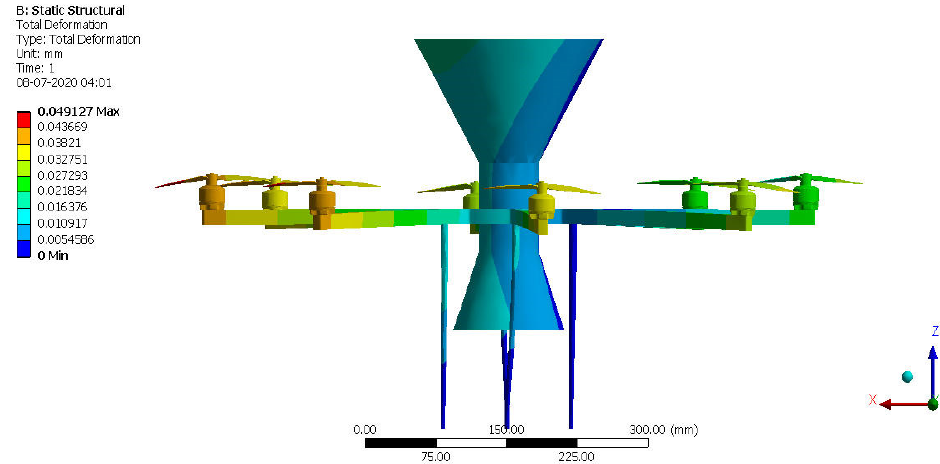
Figure 32. Variations of displacement in the Z direction.